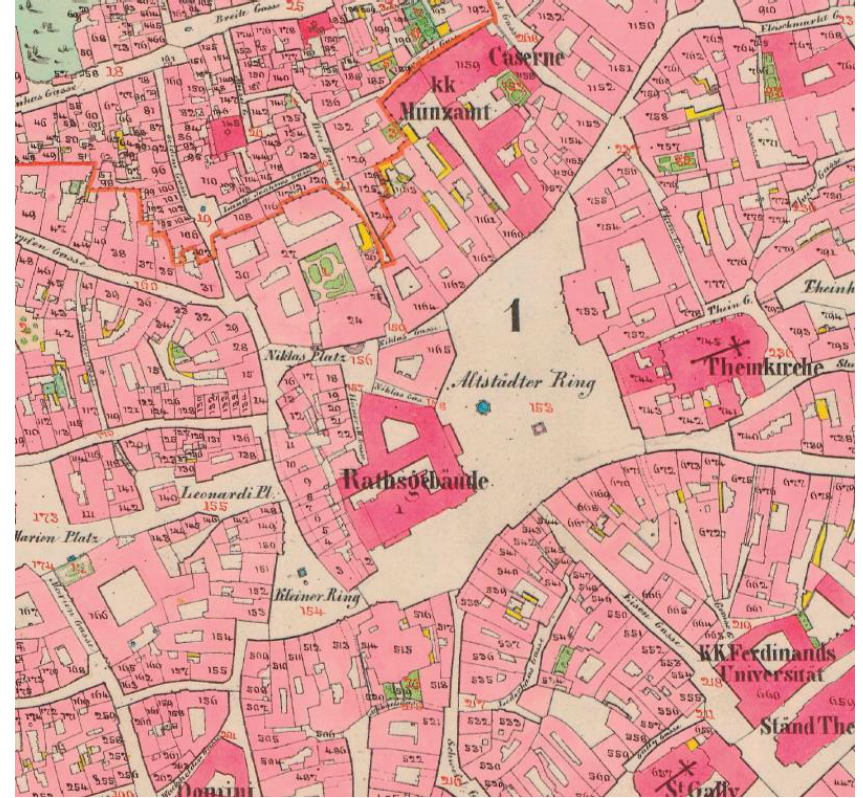
Figure 4. The map of the Old Town Square (“Altstädter Ring”) from 1842 (by CUZK, the State Figure 4. ThemapoftheOldTownSquare(“AltstädterRing”)from1842(byCUZK,theStateAdministration Administration of Land Surveying and Cadastre). of Land Surveying and